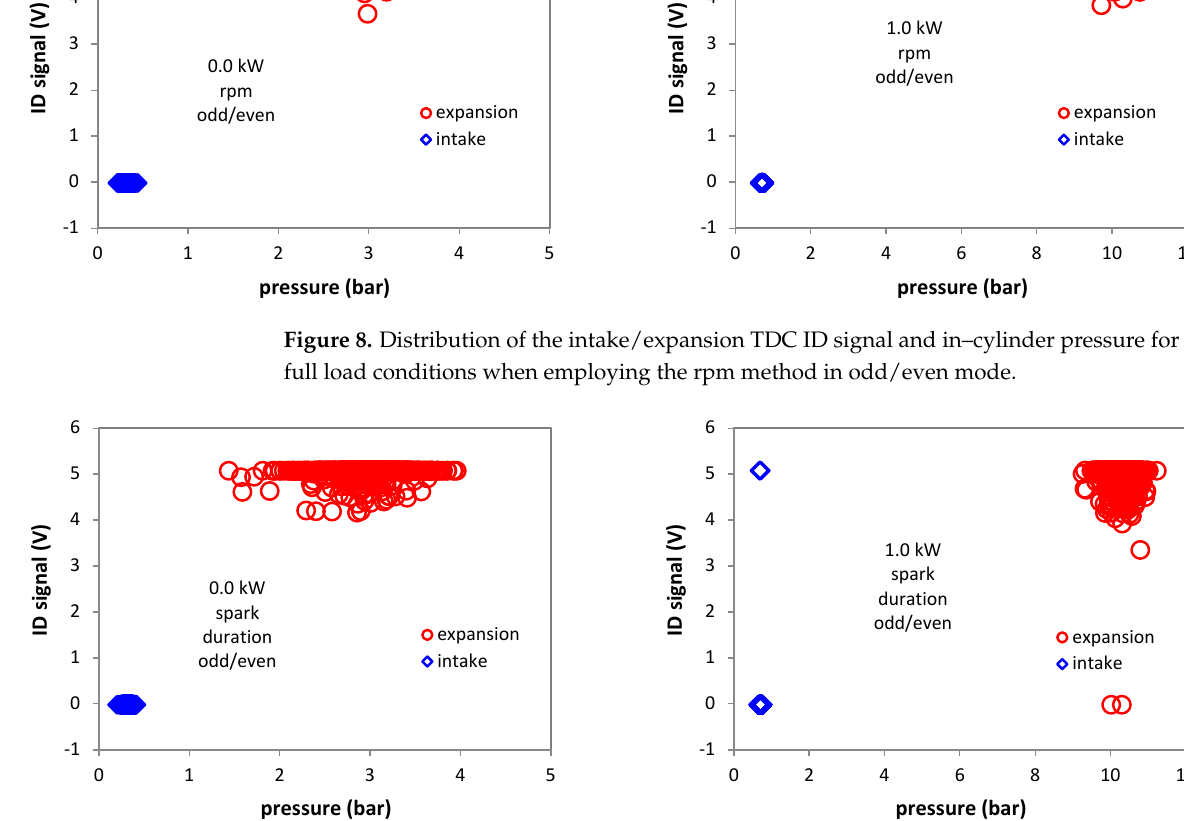
Figure 8. Distribution of the intake/expansion TDC ID signal and in–cylinder pressure for idle and full load conditions when employing the rpm method in odd/even mode.